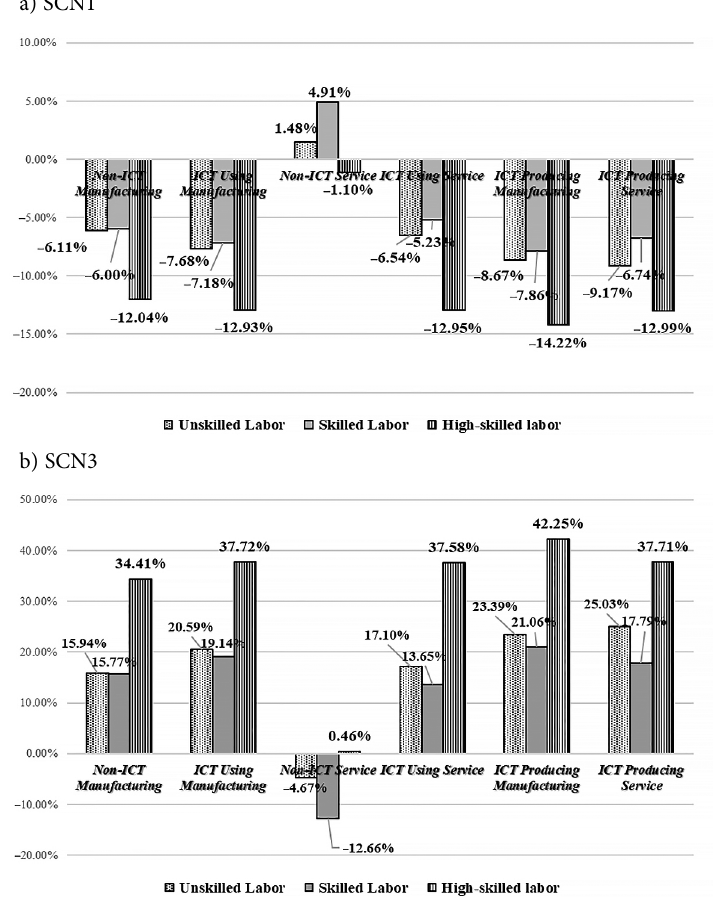
Figure 7. Differences in labor demand from the BAU in 2030 by industrial type